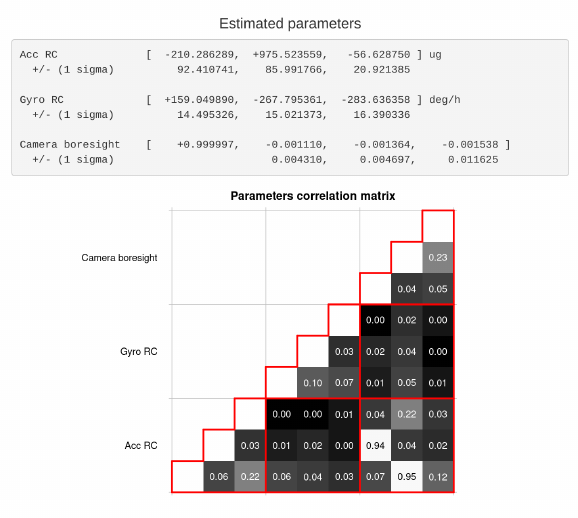
Figure 5. Estimated parameters and their absolute correlation